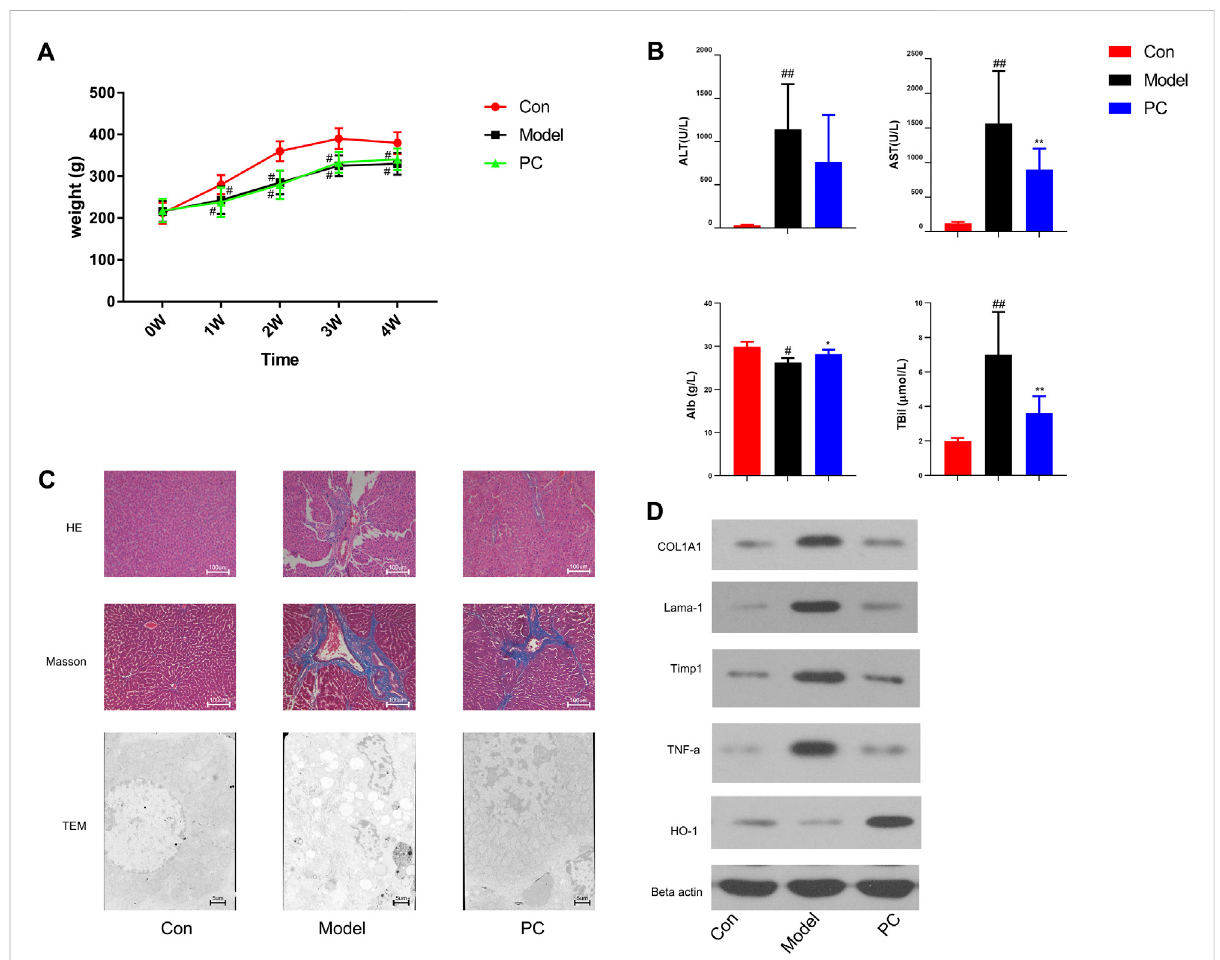
FIGURE 7 Evaluation of the therapeutic effect of P. chinense in CCl 4 -induced liver fi brosis rats. (A) Body weight change (mean ± SD). (B) Levels of serum ATL, AST, Alb, and TBil in different groups. (C) HE staining (×100), Masson staining (×100), and TEM scanning (×500) of liver tissues in each group. (D) ExpressionsofCOL1A,Lama-1,Timp1,TNF- α ,andHO-1inratlivertissuesweredetectedbyWesternblot.Thedataarepresentedasthemeans±SDs oftheresultsfromthreeindependentexperimentsandwereanalyzedbyANOVA. # p < 0.05, ## p < 0.01comparedtothecontrolgroup,and p p